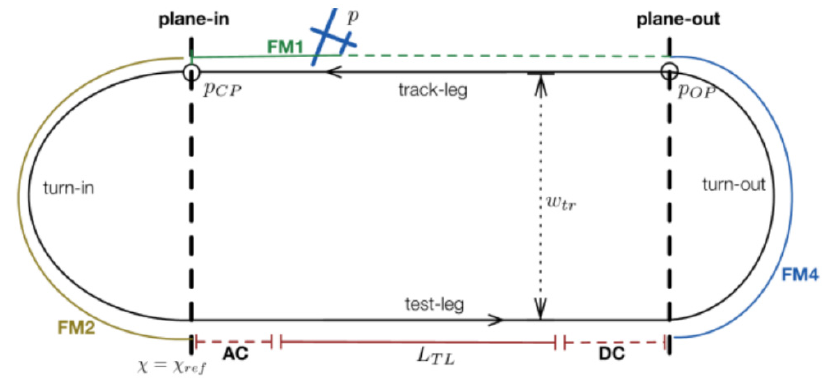
Figure 16. Test-leg for the FLEXOP